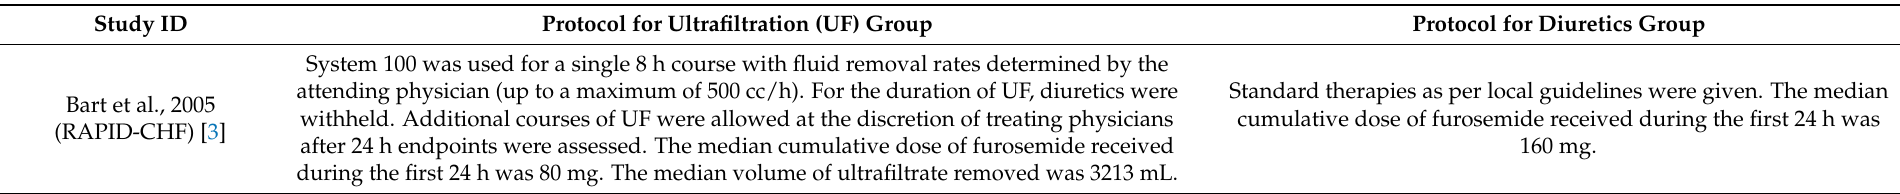
Table 2. Summary of study